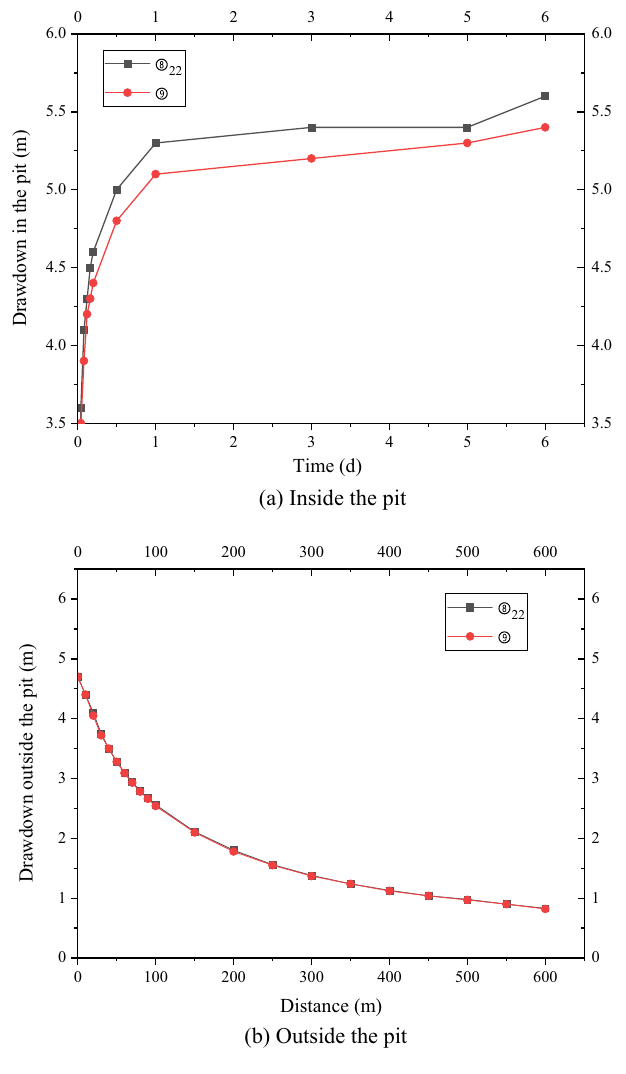
Figure 5. Variation curve of the drawdown with